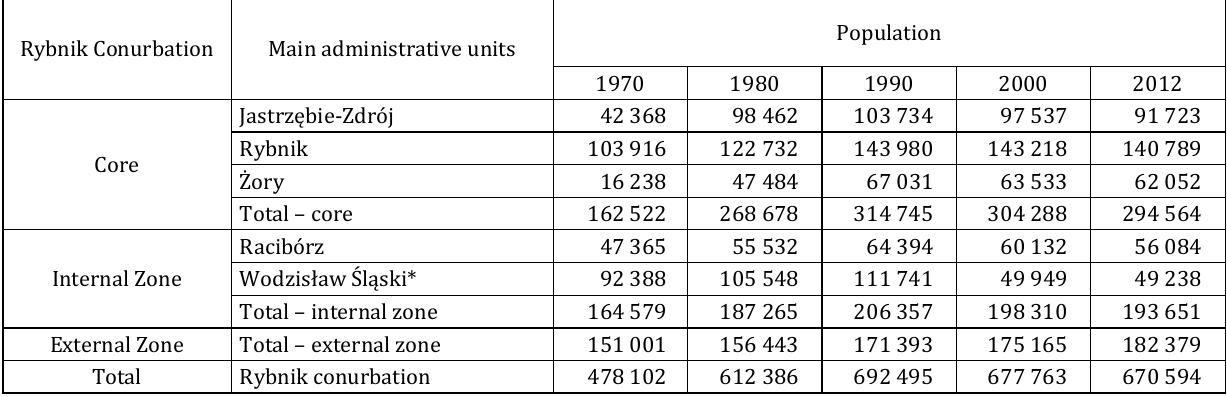
Table 1. Population changes in the Rybnik conurbation, 1970–2012 (authors elaboration based on Bank Danych Lokalnych GUS; Rocznik Statystyczny Województwa Katowickiego, 1979, 1981, 1991, WUS, Katowice)